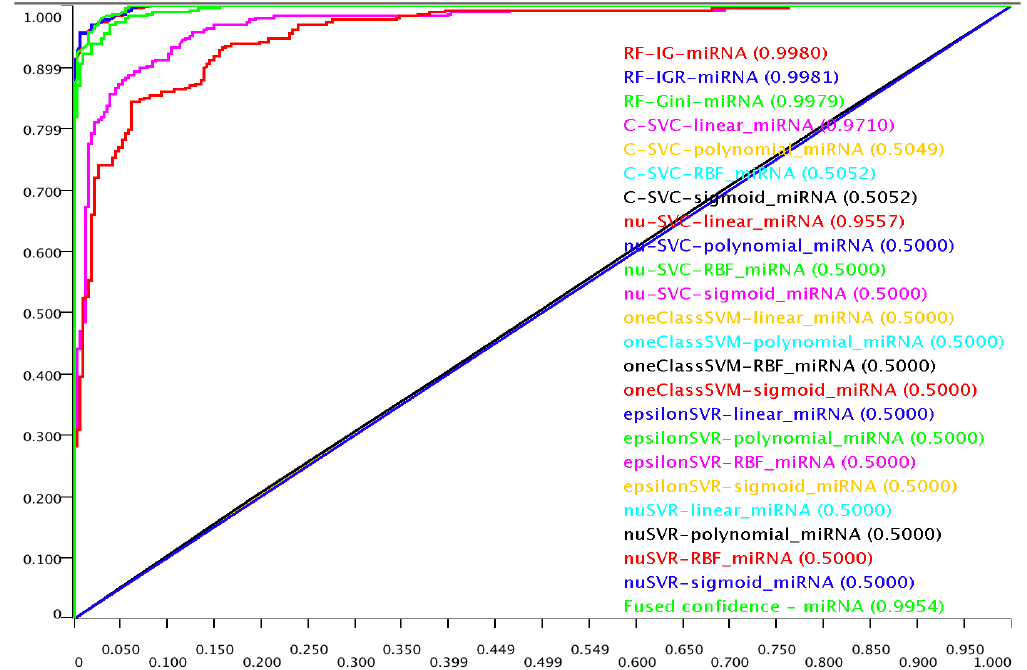
Figure 2: ROC curve graph from the case virus positive data set is used for model generation. False positive rate (x-axis) and true positive rate (y-axis) values are shown for different scenarios. IG: Information Gain; IGR: IG Ratio; Gini: Gini Index SVM types: C-SVC, nu-SVC, one-class SVM, epsilon-SVR, nu-SVR; Kernels: linear, polynomial, RBF: radial basis function,